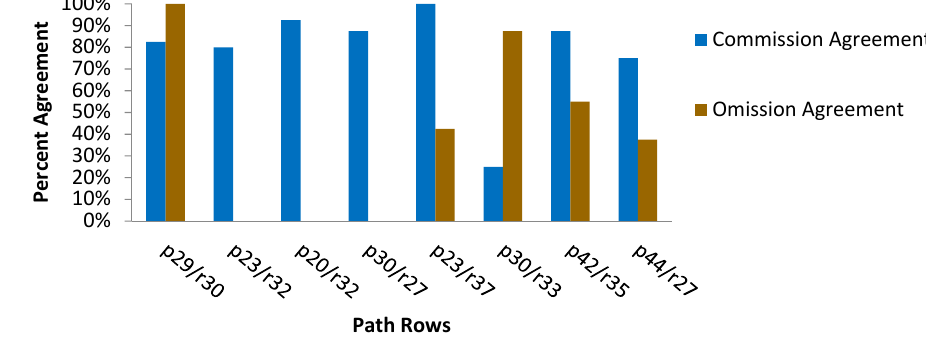
Figure 8. Agreement/disagreement between referenced data and model output (commission and omission).